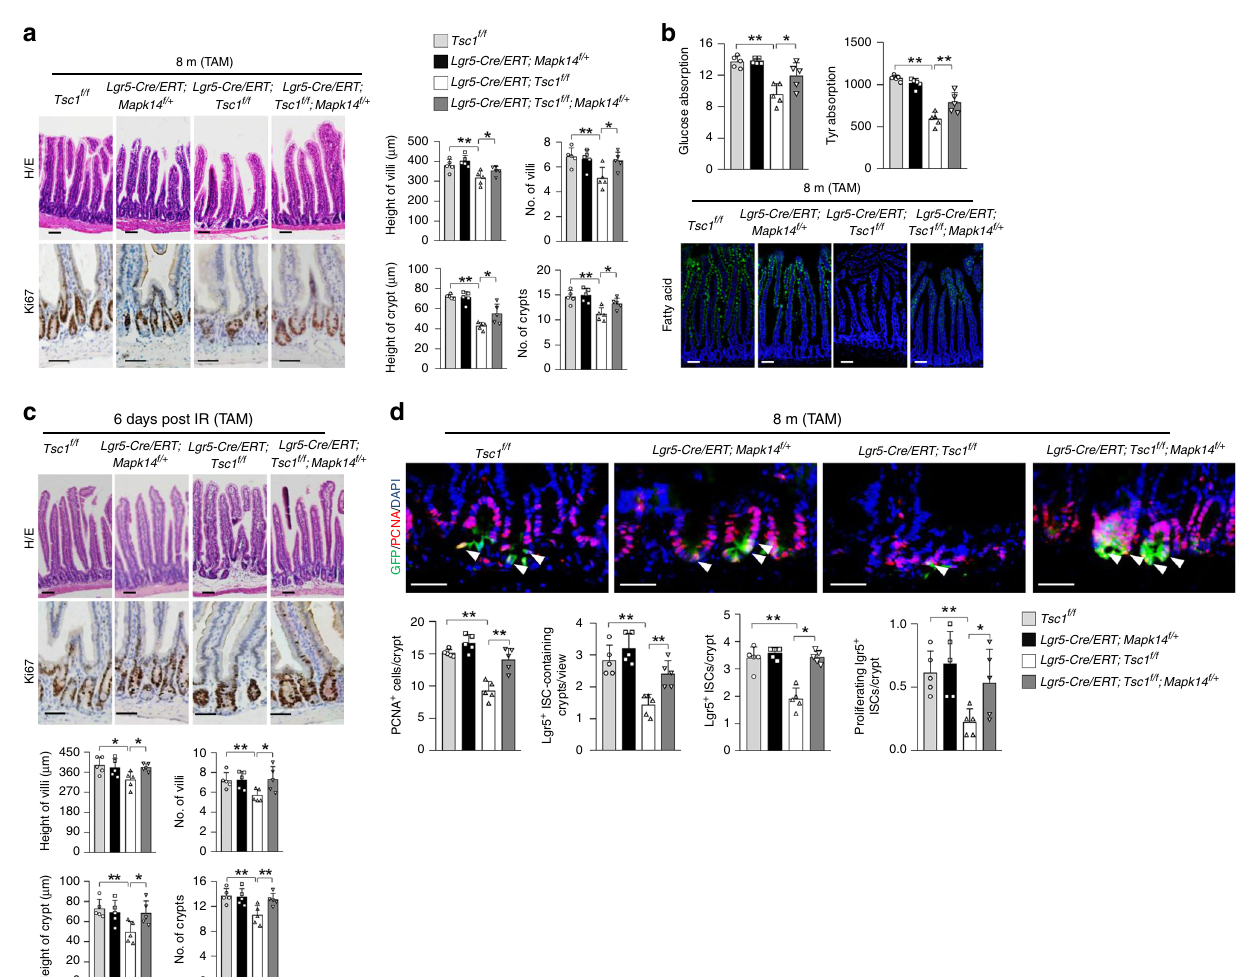
Fig. 5 MKK6-p38 α MAPK signaling mediates villus premature aging caused by Tsc1 de fi ciency. a – c Mapk14 haplode fi ciency rescued the deterioration in villus structures ( a ), decreased nutrient absorption activities ( b ), and compromised regeneration ( c ) at 8 month of age. Data are expressed as mean ± SEM. N = 5 mice per group. * P < 0.05, ** P < 0.01 (determined using Student ’ s t test). d Mapk14 haplode fi ciency rescued the decreases in the numbers of ISCs and proliferating ISCs in 8-month-old Lgr5-GFP-CreERT;Tsc1 f/f mice. The intestinal sections were immunostained for PCNA, and cells positive for PCNA and GFP were counted and normalized to the number of Lgr5 + ISCs. Bottom panels: quantitation data (mean ± SEM). N = 5 mice per group. * P < 0.05, ** P < 0.01 (determined using Student ’ s t